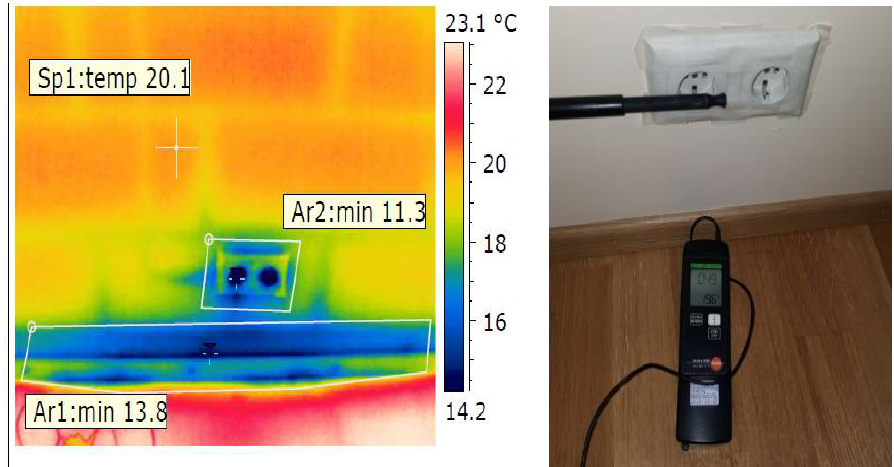
Figure 7. Defects of electric installation influencing the airtightness of construction.